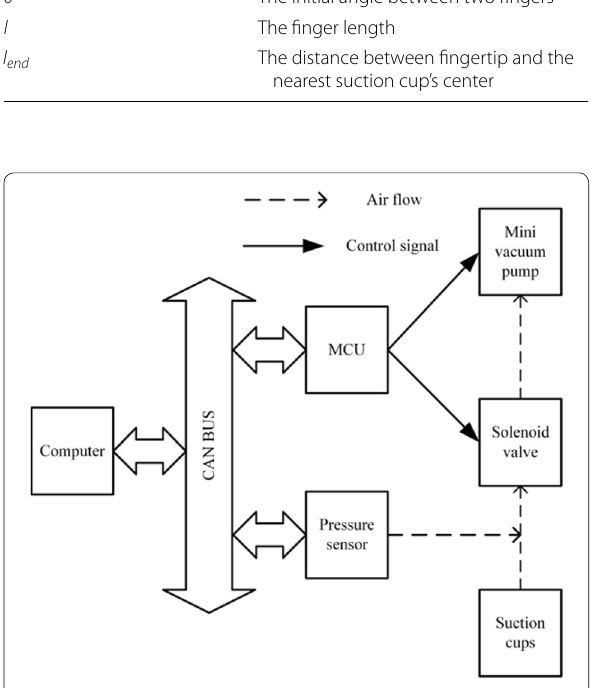
Figure 2 Control framework of vacuum system